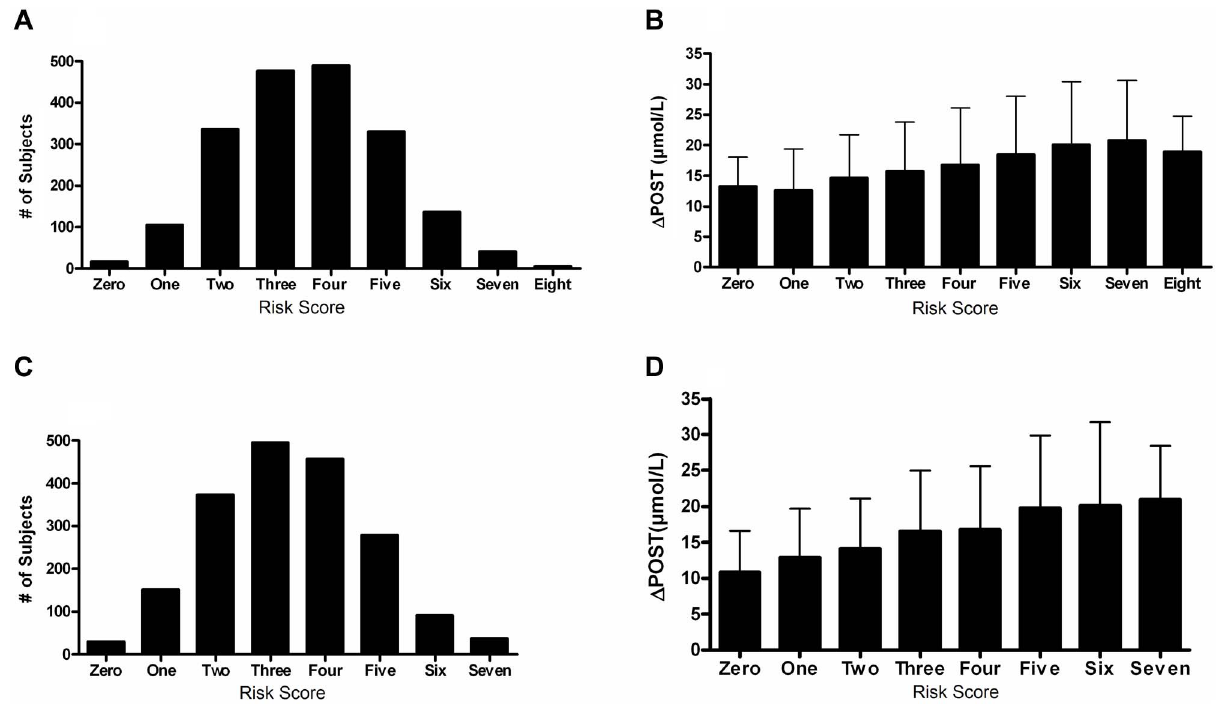
Figure 5. Risk score in FHS and VISP studies. (A) Distribution of risk scores among the FHS sample shows a normal distribution. Y-axis represents the number of individuals who have the given risk score seen on the x-axis. (B) X-axis represents the number of risk variants per subject in FHS. Y-axis represents the average D POST value for each group containing a specific risk score. (C) Distribution of risk scores among the VISP sample shows a normal distribution. Y-axis represents the number of individuals who have the given risk score seen on the x-axis. (D) X-axis represents the number of risk variants per subject in VISP; Y-axis represents the average D POST value for each group containing a specific risk score. Risk variants considered were SNPs at each of the 5 loci most significantly associated with D POST in the meta-analysis. For each SNP a score of 0 was applied for homozygous non-risk variant, 1 for heterozygous at risk variant and 2 for homozygous at risk variant, derived from dosage values of 1000genomes imputation.